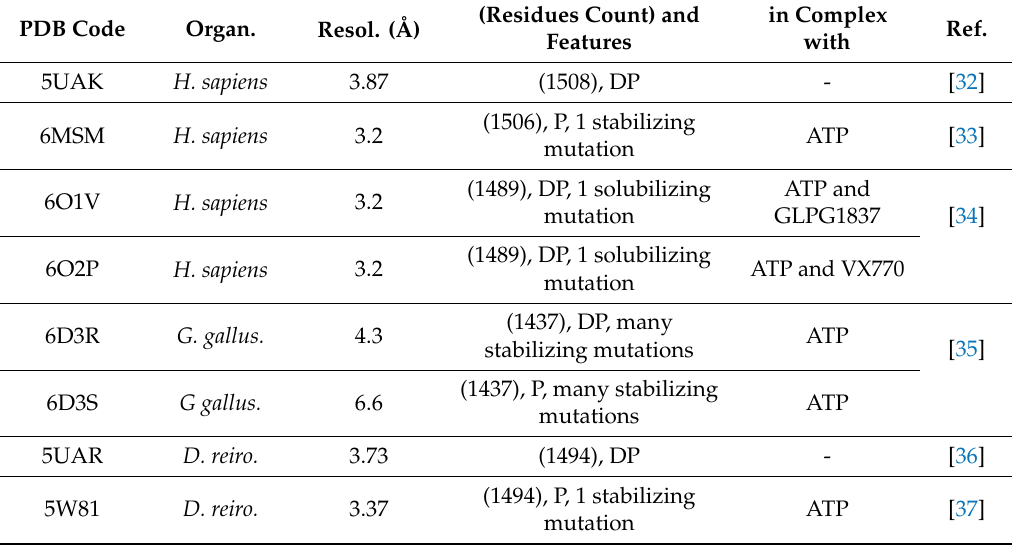
Table 2. Structural data for the complete wild type (WT) CFTR protein as determined by cryoelectron microscopy (cryo-EM) and listed in the PDB. PDB Code Organ. Resol. (Å)